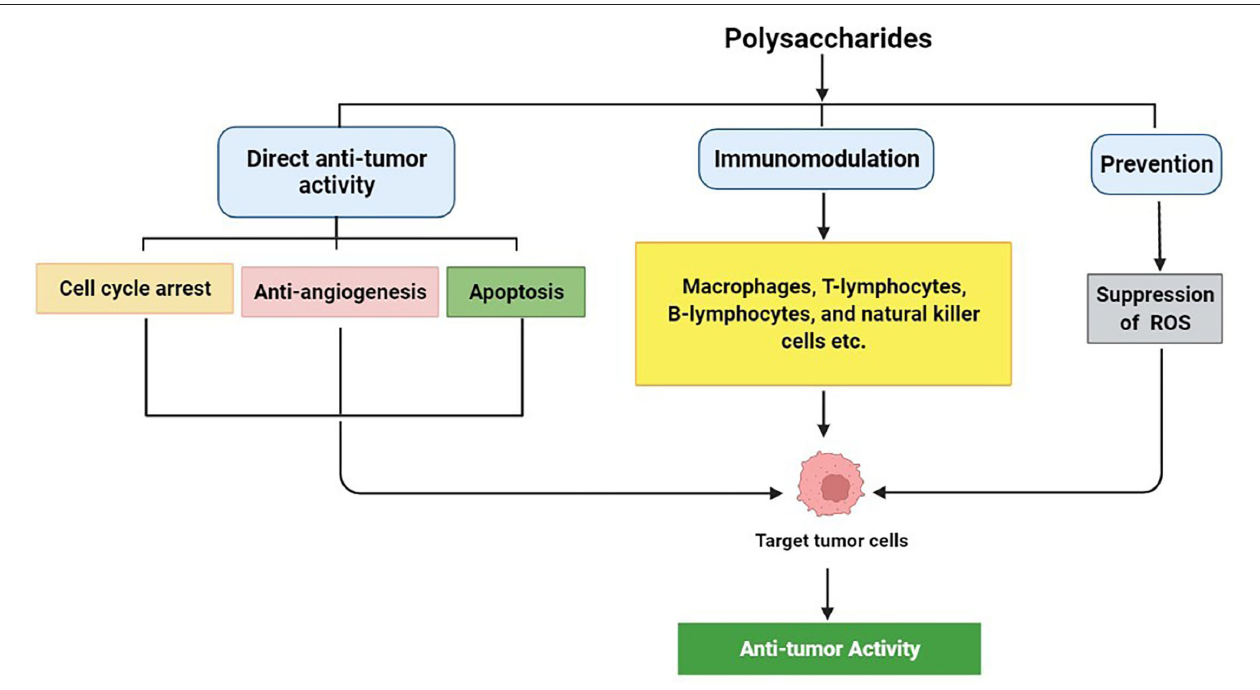
FIGURE 1 | Summary of anti-tumor mechanisms of